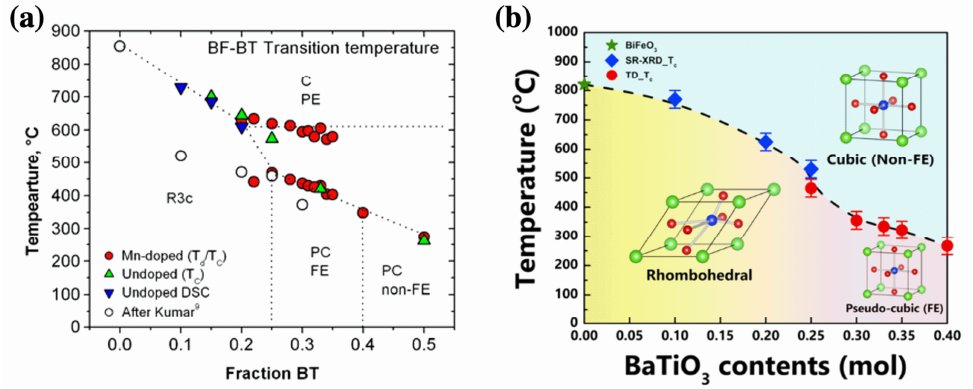
Figure 7. Phase diagram of BiFeO 3 -BaTiO 3 system; ( a ) reported by Eitel. Reprinted with the permis- sion of [75]. Copyright © 2009 John Wiley and Sons. ( b ) Reported by Kim. Reprinted with the permission of [72]. Copyright © 2017 AIP Publishing.